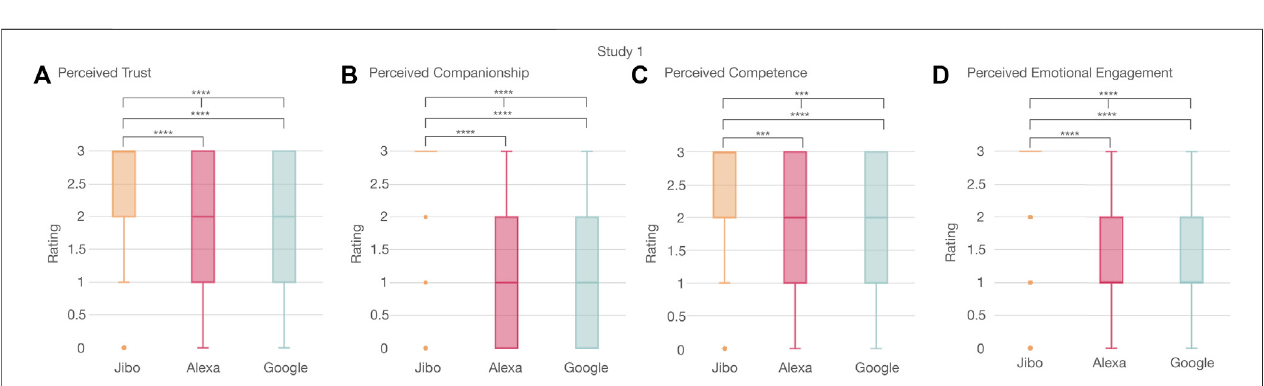
FIGURE6 | Signi fi canttrend in perceived trust, companionship,competence, and emotional engagement ofvoice agents between participants showing Jibowas signi fi cantly perceived as (A) more trustworthy, (B) more like a companion, (C) more competent, and (D) more emotionally engaging than Alexa or Google.